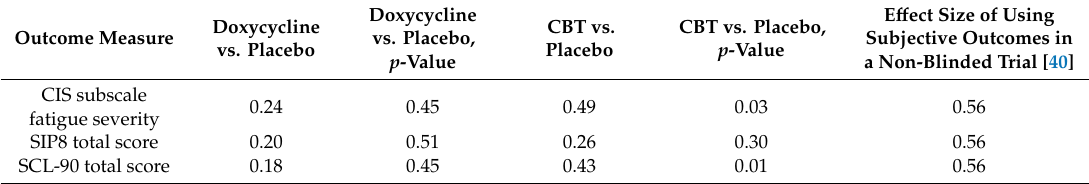
Table 1. The standardized e ff ect size on fatigue, disability and psychological distress at the end of treatment.